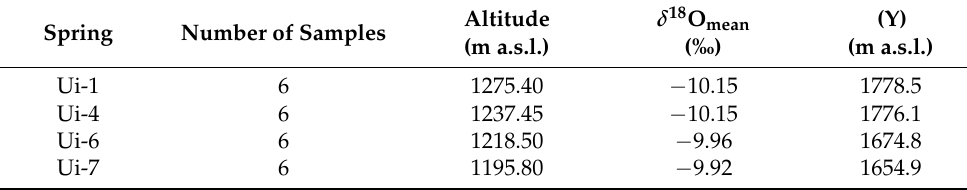
Figure 5. Average recharge altitude estimation. Table 4. Estimated average recharge altitude (Y) of springs in the Urbas landslide.